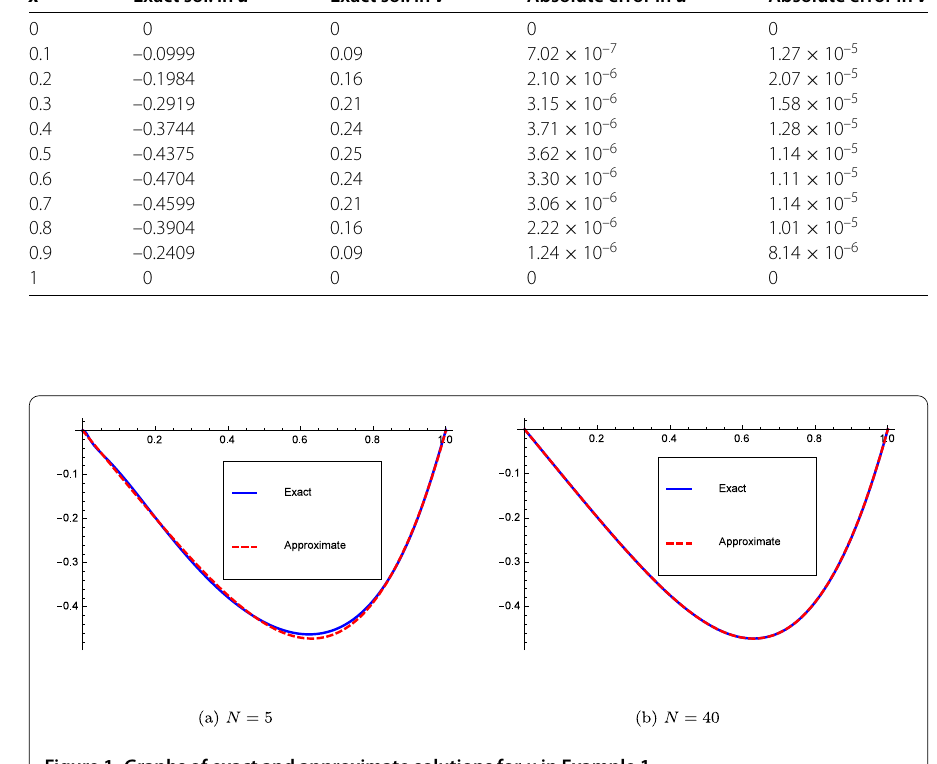
Figure 1 Graphs of exact and approximate solutions for u in Example 1.